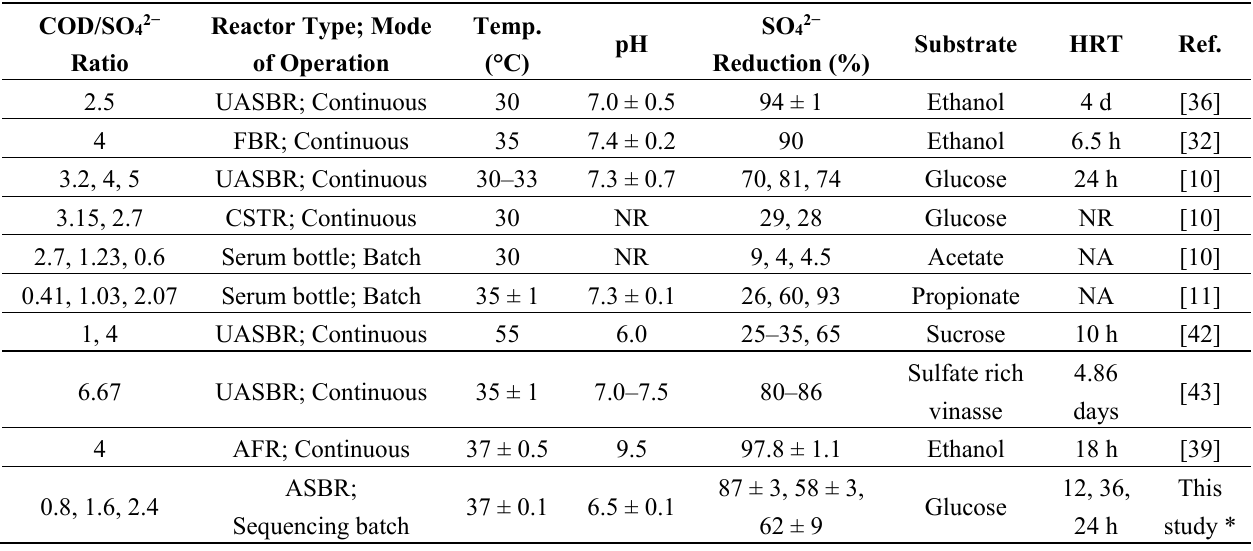
Table 4. Comparison of percent sulfate reduction under different operational